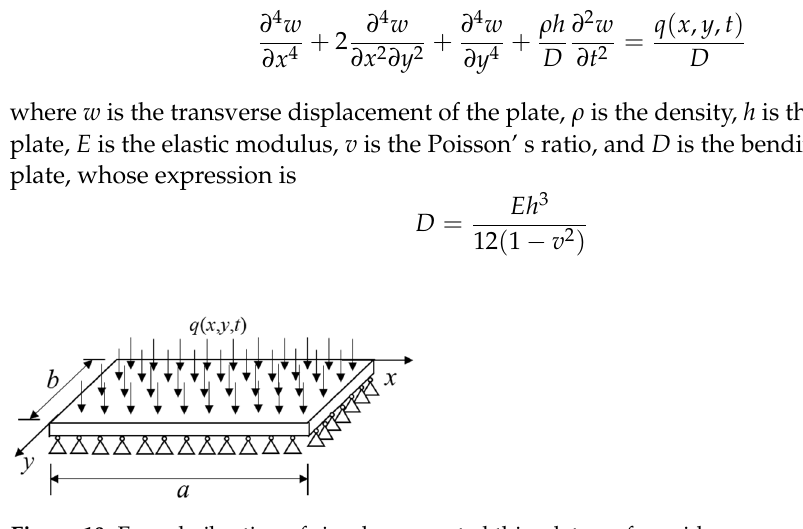
Figure 10. Forced vibration of simply supported thin plate on four sides.